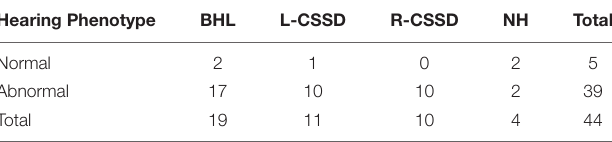
TABLE 3 | The Coat color and the hearing loss of 5 th